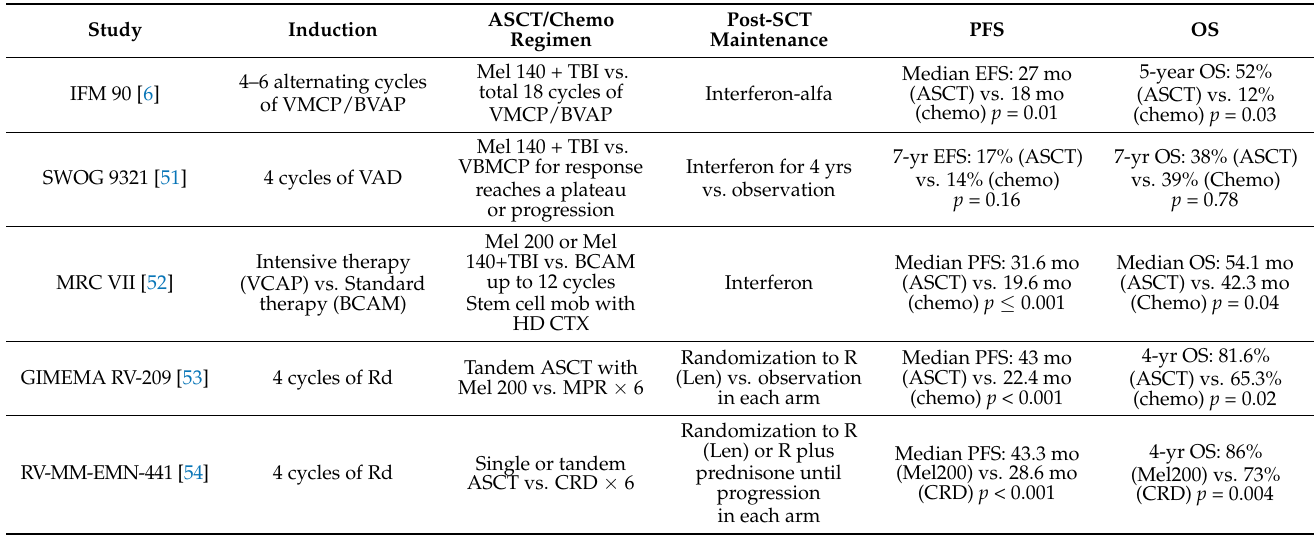
Table 1. Randomized studies comparing ASCT with conventional chemotherapy as consolidation